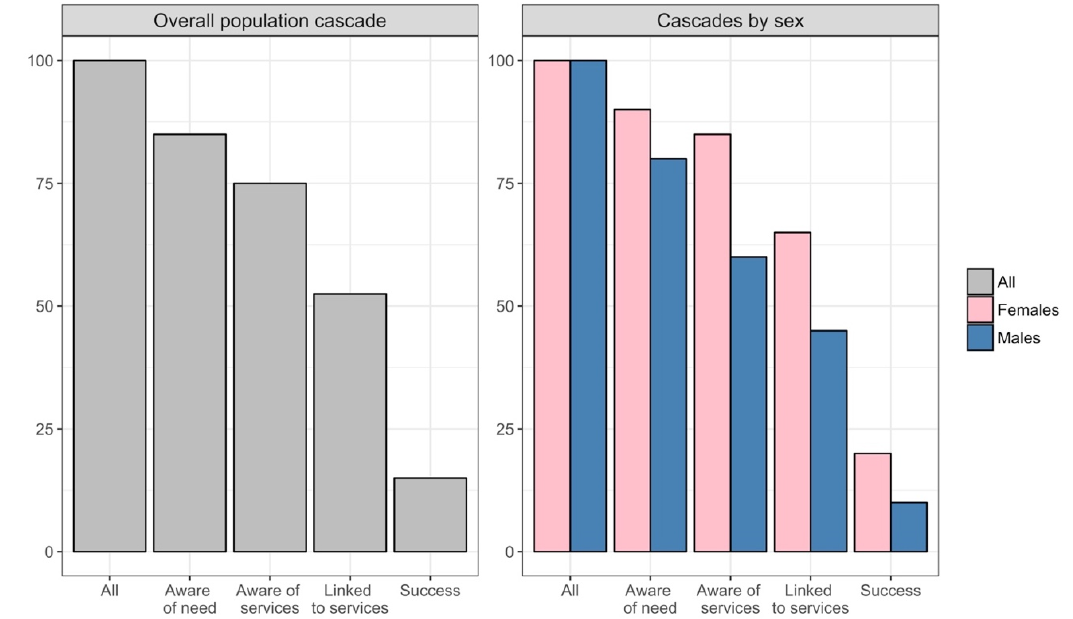
Figure 1. A typical cascade presents the proportion of the total target population that have attained each of the sequential steps of engagement in the path towards a successful outcome. The left panel is aggregated across the total population, and the right panel shows the same information but disaggregated by